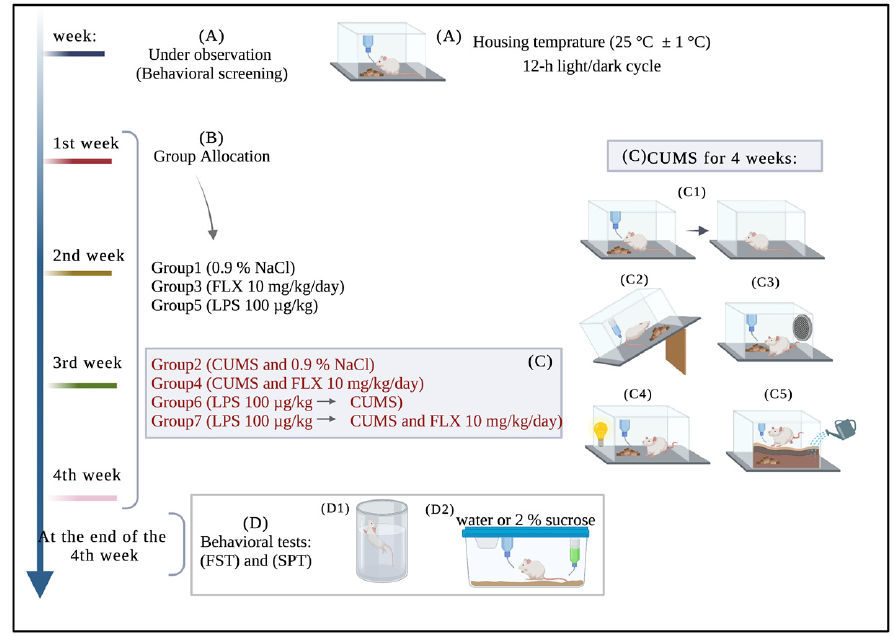
Figure 1. Experimental Protocol: (Week 0) the rats were under observation. Thereafter, during the four weeks (Week 1 to Week 4) rats were divided into stressed and non-stressed groups and chronic unpredictable mild stress protocol was applied: (C1) food and water deprivation, (C2) cage tilting, (C3) intermittent noise, (C4) alteration of light/dark cycle, (C5) bedding alteration and wetting. At the end of the 4th week behavioral tests were applied: Forced Swim Test and Sucrose Preference Test. NaCl: sodium chloride (normal saline); CUMS: chronic unpredictable mild stress; FLX: fluoxetine; LPS: lipopolysaccharide; FST: forced swim test; SPT: sucrose preference test. Behavioral